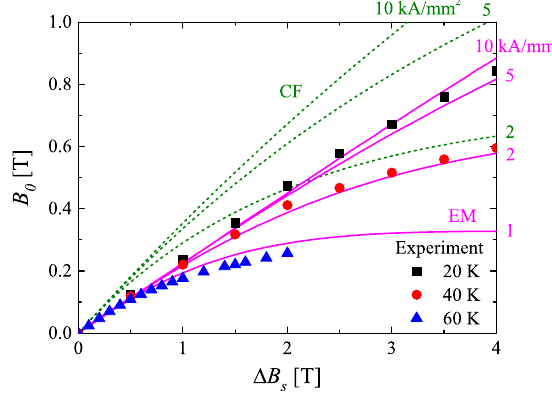
FIG. 8. Comparison of experiment and calculation: dependence of B 0 on Δ B . s